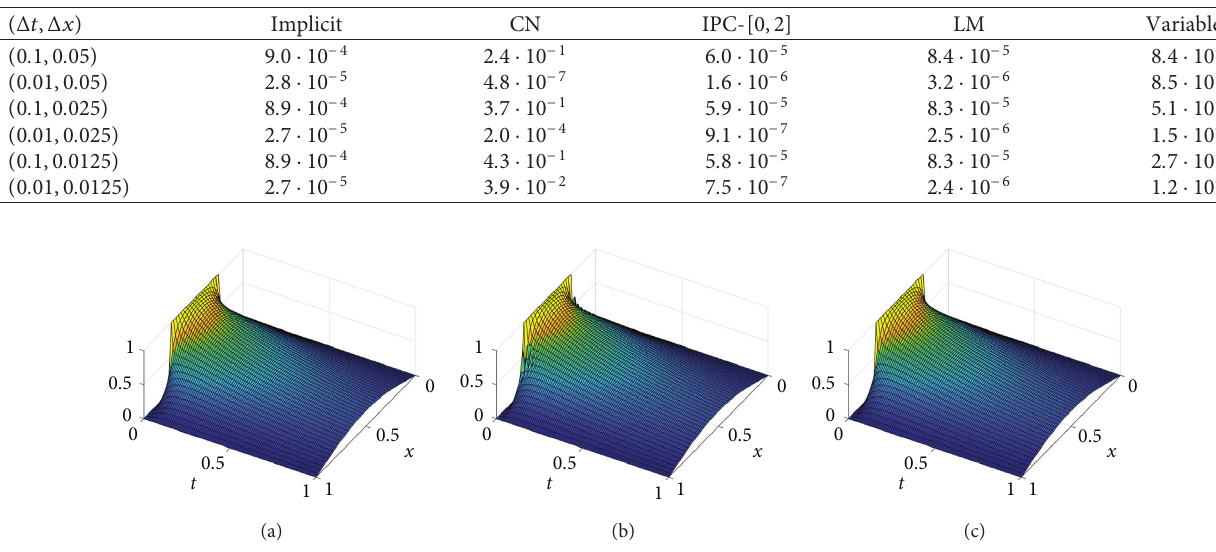
[ T ] for (15) at T � 1 . 0. ∞